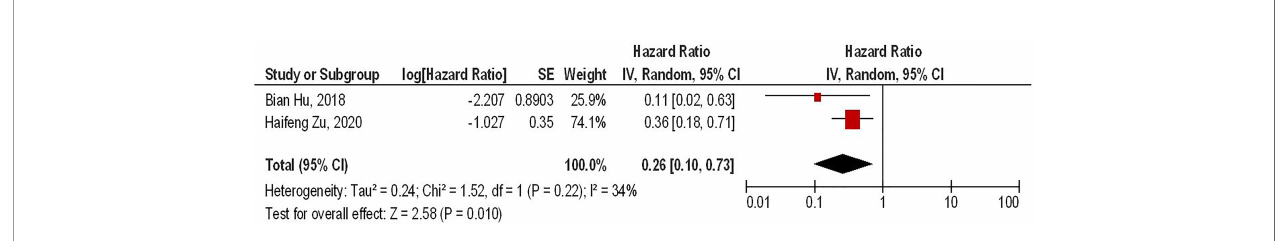
FIGURE 4 | The forest plot of studies evaluating the effect of PD-1 knockdown on the survival of animal models treated with third-generation CAR-T